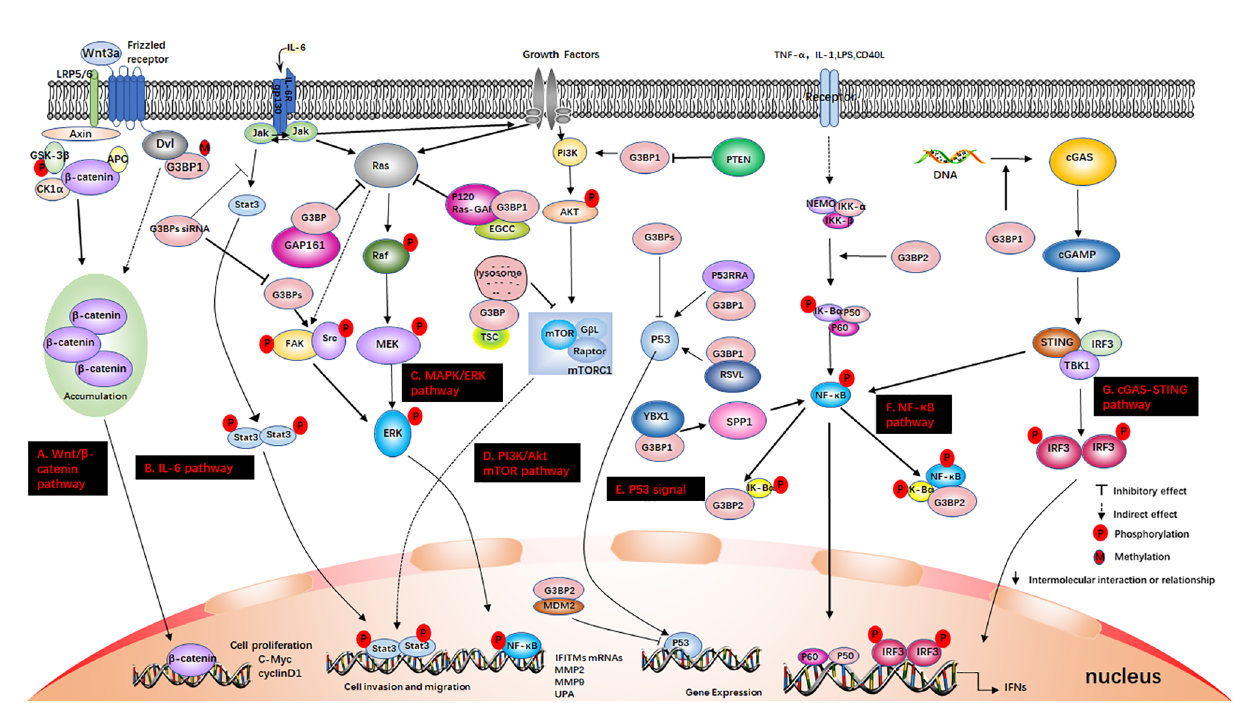
FIGURE 3 | G3BP participates in some signaling pathways. (A) The Wnt/ b -catenin pathway. Axin, and adenomatous polyposis coli (APC) activate glycogen synthase kinase ‐ 3 beta (GSK-3 b ). This causes the degradation of b -catenin, which is mediated by proteasomes. Wnt3a activates this pathway. Ctnnb1 mRNA in the Dishevelled3 (Dvl3) complex has the ability to resist the degradation of b -catenin and can also stimulate the rapid accumulation of b -catenin in cells. This causes the translocation of b -catenin to the nucleus and stimulates the activation of genes. (B) IL-6 pathway. IL-6 binds to IL-6R and glycoprotein 130 (gp130) on the membrane, dimerizes gp130, and initiates intracellular signals. First, Janus kinase (JAK) is activated, and then STAT3 is phosphorylated to form a homodimer, which is transferred to the nucleus to induce the expression of target genes. IL-6 can also activate the Src, MAPK cascade and PI3K signaling pathway; (C) MAPK/ERK pathway. Growth factors bind to speci fi c receptors on the cell membrane to form dimers. Ras dissociates from GDP and binds to GTP. Ras is fi rst activated, and it further activates the serine/threonine protein kinase (Raf-1), which phosphorylates it, thereby activating MEK; (D) PI3K/Akt mTOR pathway. When growth factor binds to receptors, it can change the protein structure of Akt and further activate the downstream target molecule, mTOR. The tumor suppressor protein PTEN can dephosphorylate Akt and reduce its activation. It can also prevent downstream signal transduction, which is regulated by Akt. It is also a negative regulator of PI3K. (E) P53 signal. P53 is a tumor suppressor gene that can respond to various cell signals such as DNA damage, oncogene expression, nutrient deprivation, and ribosome dysfunction. P53 regulates the genome integrity, cell cycle arrest, and cell apoptosis; (F) NF- k B pathway. When the upstream signal factor binds to the receptor on the cell membrane surface, the receptor conformation changes, and the signal is transmitted to IKK. I k B a is phosphorylated under the action of IKK- a / b , and the phosphorylated I k B a is then ubiquitinated and degraded by the proteasome to release p50/p65. Subsequently, the p50/p65 dimer exposes the nuclear localization sequence (NLS), rapidly enters the nucleus from the cytoplasm, and combines with speci fi c sequences on the nuclear DNA to promote the transcription of related genes; (G) cGAS-STING pathway. cGAS is an important cytoplasmic sensor for DNA and the cGAS-STING pathway is very important for the defense against viral infections. cGAS recognizes exogenous DNA and catalyzes the synthesis of cGAMP. Then, cGAMP binds to and activates STING, recruits TBK1, and phosphorylates IRF3 and activates it to induce the production of